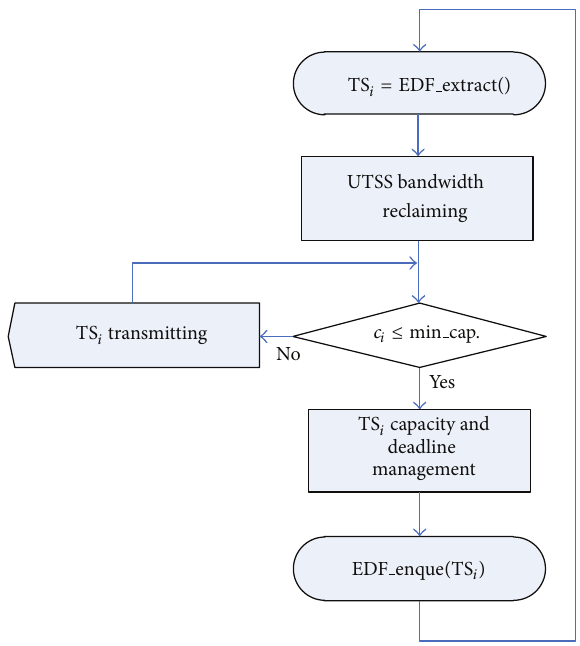
Figure 2: EDF-based (WCBS) + UTSS scheduling cycle.